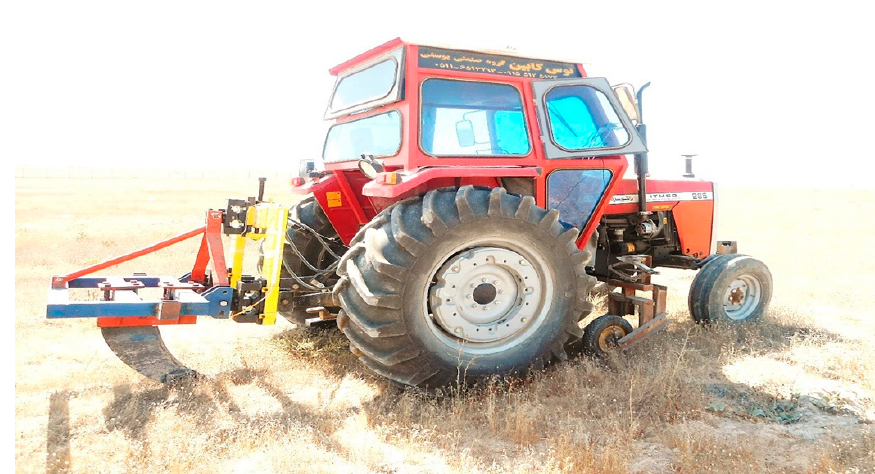
Figure 1. The instrumentation used in the